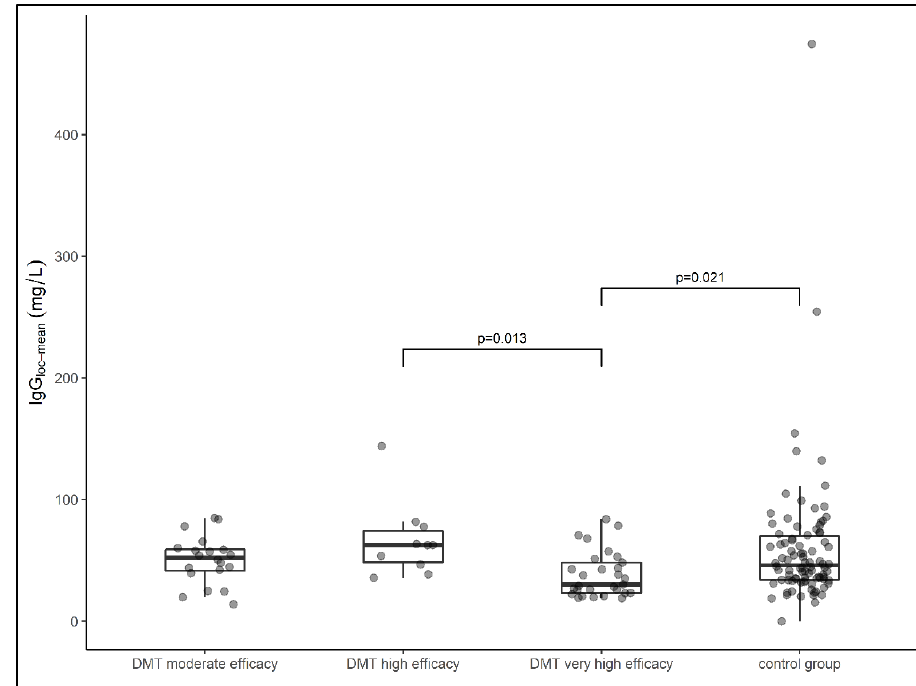
Figure 1. Data on local IgG concentrations of patient samples presented in box plots (median, first, and third quartile). Samples from patients treated with very highly effective DMT had significantly lower IgG concentrations than samples treated with highly effective DMT ( p = 0.013) and the control group ( p = 0.021). DMT—disease-modifying therapy, Ig—Immunoglobulin. Comparison between groups was performed using the Kruskal–Wallis test. The Dunn–Bonferroni test was used for post hoc analysis .